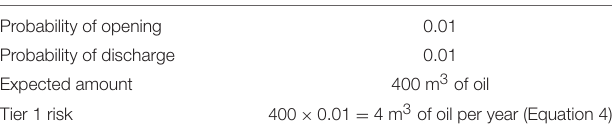
TABLE 3 | Results of a Tier 1 consequence assessment for wreck number